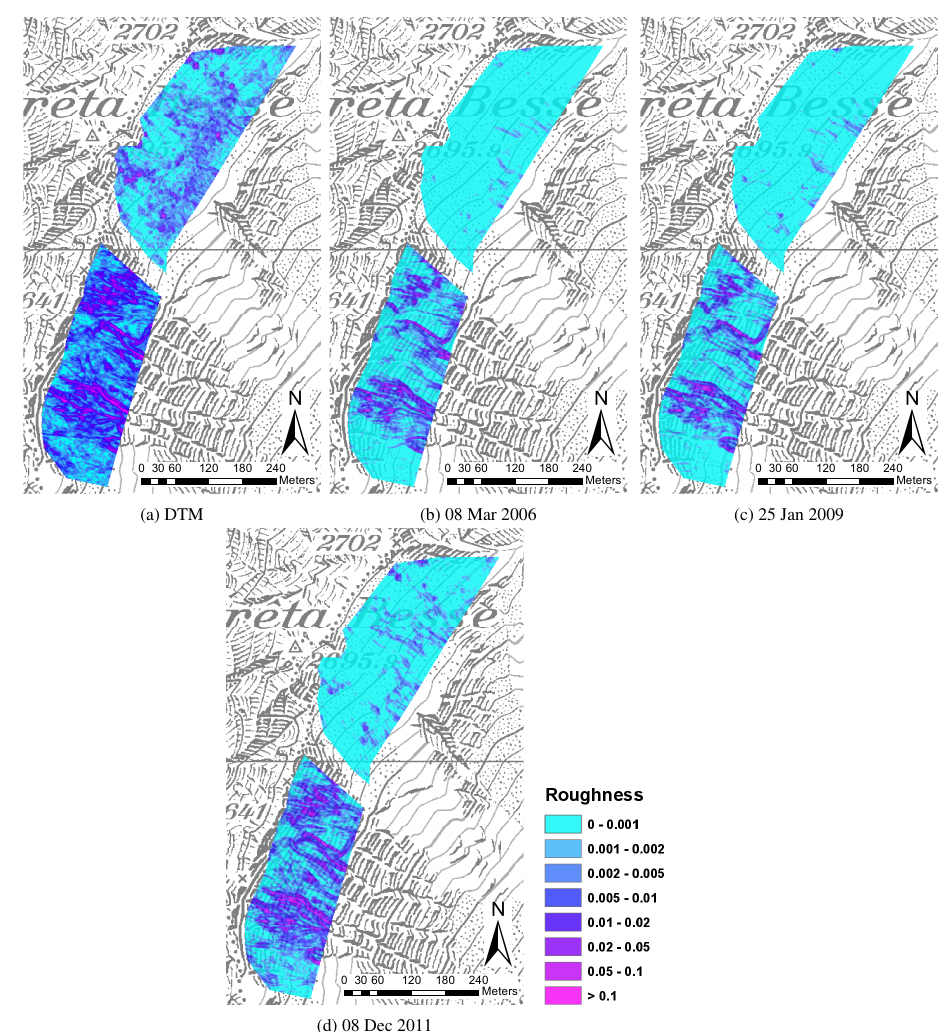
Fig. A5. Surface roughness of summer terrain and winter terrain at a scale of 5m in basins CB1 and CB2. Pixmaps © 2013 swisstopo (5704 000 000).